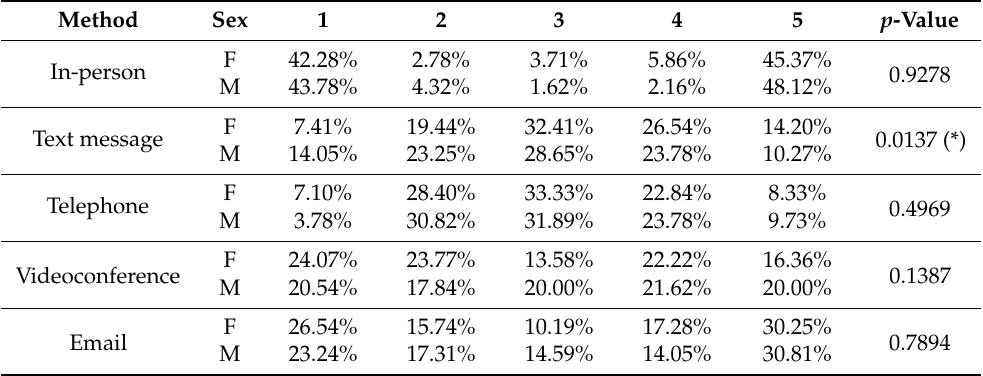
Table 4. Preferred method for conducting a conversation on a topic that is considered important. Method